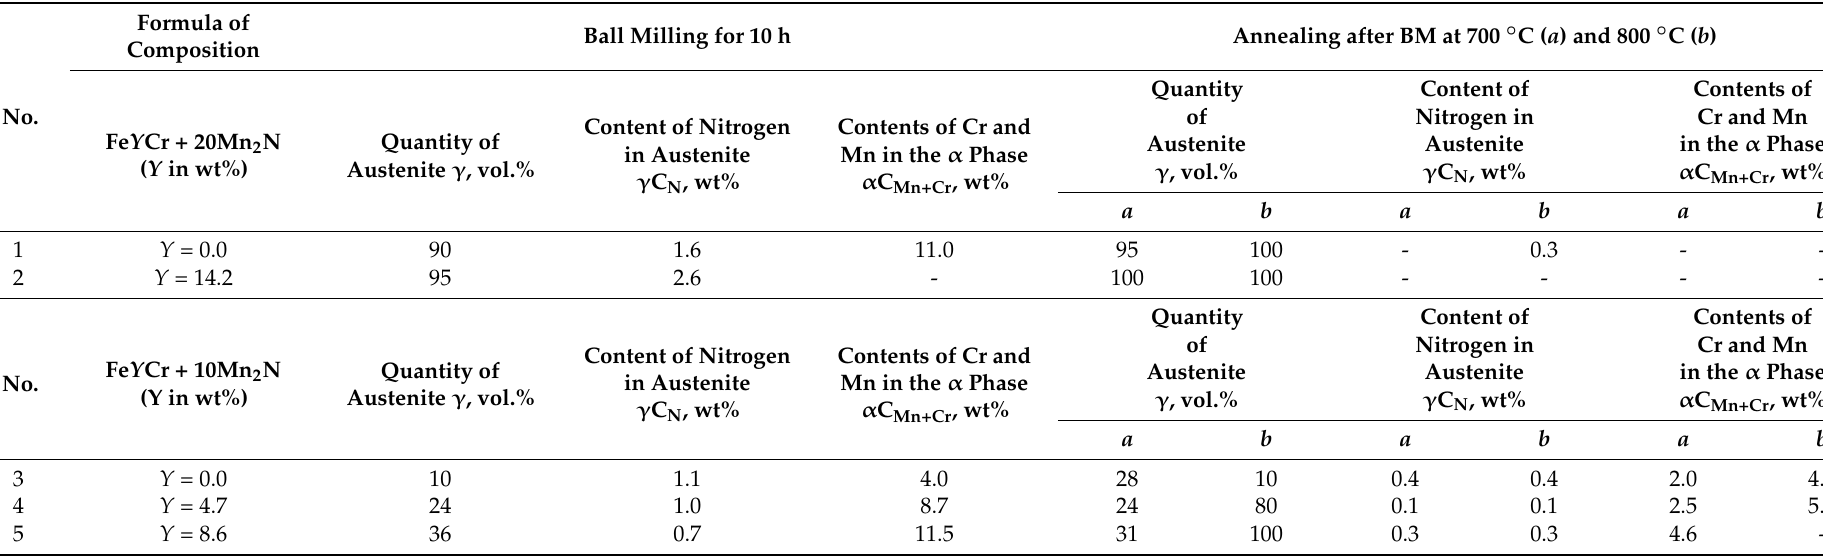
Table 2. The formula of composition, the content of alloying elements, and the quantity of austenite in the MA alloys of series B after the ball milling and subsequent anneals.